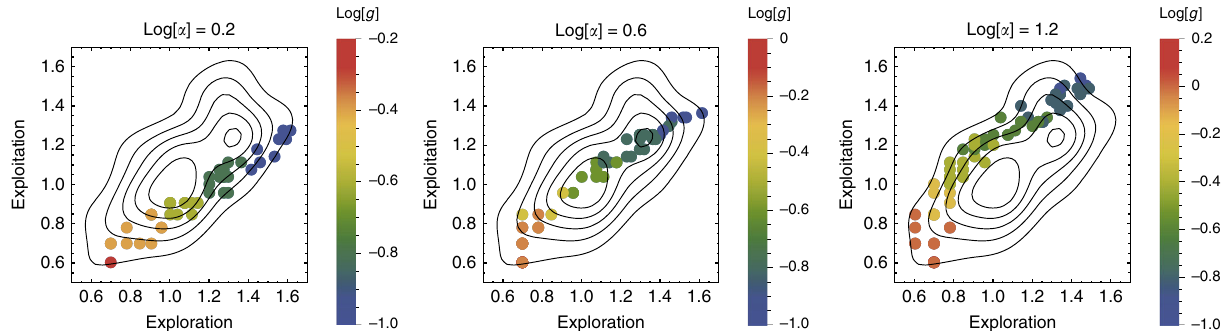
Fig. 5 FCD model captures the variation between individuals in the durations of exploration-exploitation. In the FCD circuit (Eqs. (5) and (6)), a single parameter, g , the rate of meaning accumulation, sets the correlation between durations of exploration and exploitation. Shown are different simulation runs, grouped by different α values, while g values vary according to the color bar. Small g values show a thorough slow-to-discover/slow-to-drop behavior, while large g values show a mercurial quick-to-discover/quick-to-drop behavior, both as seen in the behavioral data. The second parameter, α , the attention threshold to saturation increase, controls the perpendicular principal component of behavioral data variation (see Supplementary Fig. 4, for similar simulation of the non-FCD circuit, Eqs. (7)